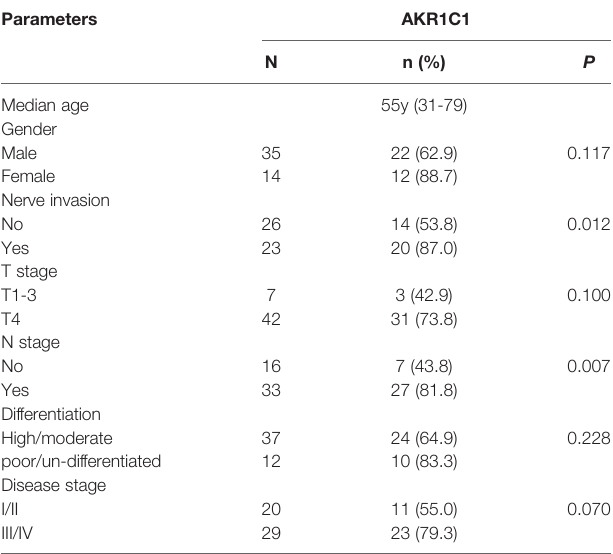
TABLE 1 | Correlation between AKR1C1 expression and clinicopathological factors. Parameters